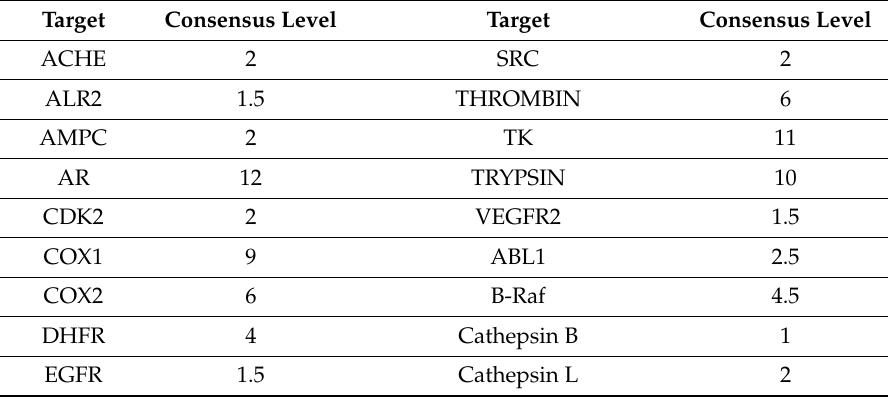
Table 3. The consensus docking (score) results of the 60 targets. The consensus level represents the number of docking procedures that are able to rank the proper target of each ligand into the top 10% of the considered targets. For each target, the consensus level is the median of the single consensus values calculated for its 10 corresponding ligands.